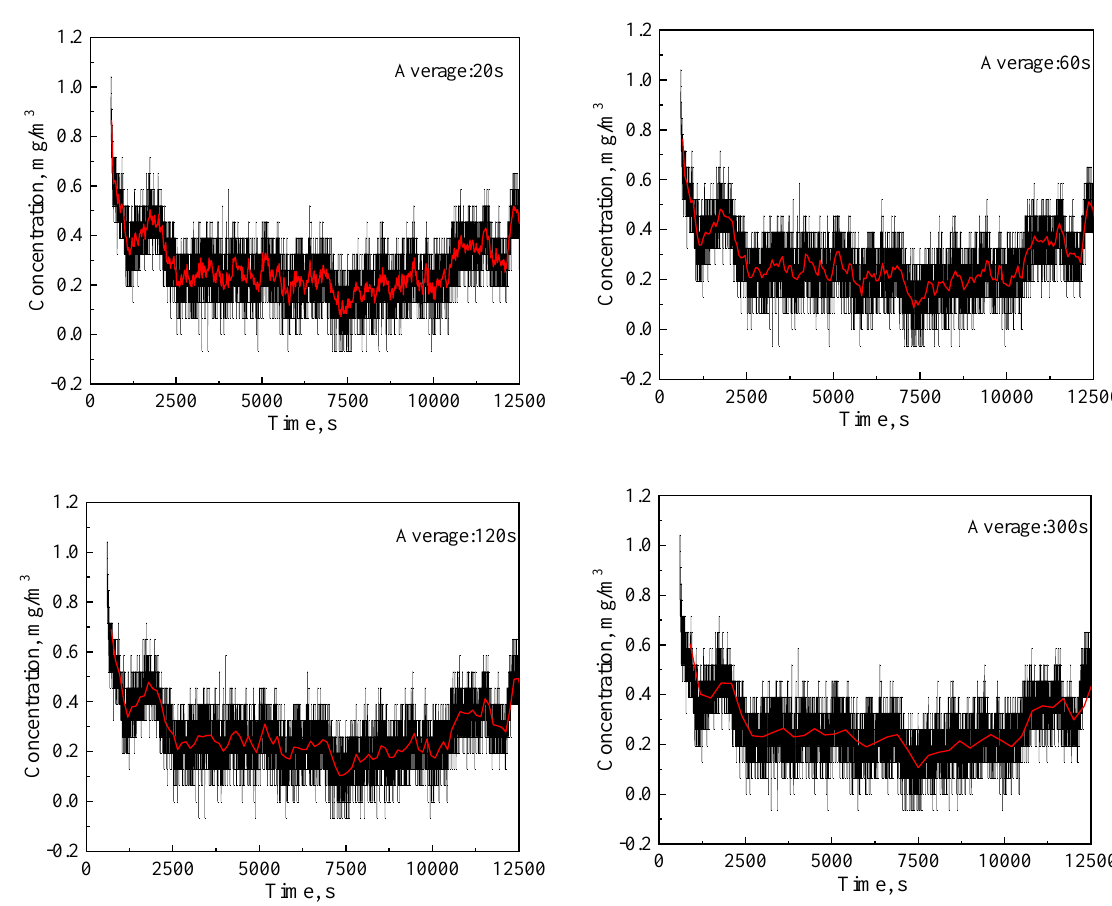
Figure 6. PM 2.5 concentration ( ∆ t = 10 min) averaged every 20 s, 60 s, 120 s, and 300 s. The black line is the original concentration, and the red line is the averaged concentration.